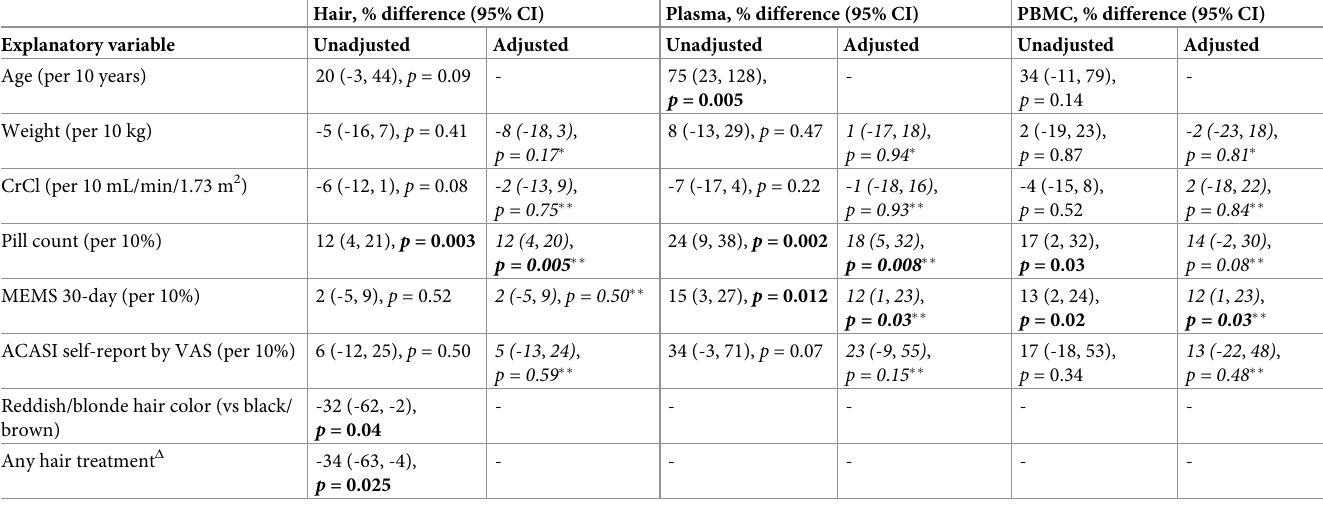
Table 5. Percent differences in tenofovir in hair, plasma and peripheral blood mononuclear cells in active arm participants, by linear regression (univariate and multivariable results presented), in the US CDC PrEP safety study. Hair, % difference (95%